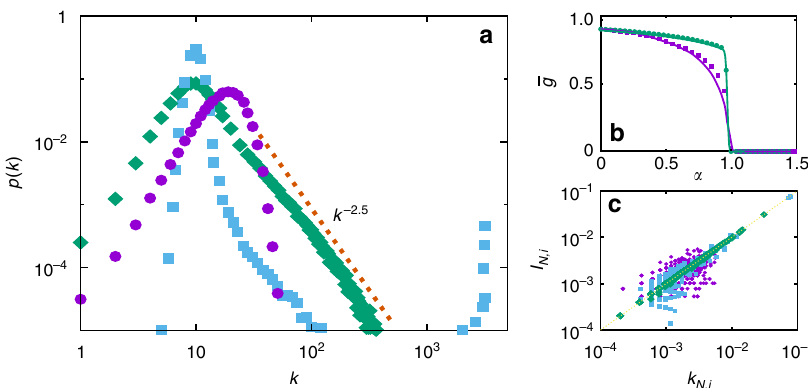
Fig. 1 Topological limit and coupling. a Stationary degree distributions p ∞ ( k ) for the three different phases: subcritical ( α = 0.8, purple circles), critical ( α = 1.0, green diamonds) and supercritical ( α = 1.2, blue squares). b Stationary homogeneity g ð α Þ for the topological limit ( γ = 1.0, purple squares), and for a different set of local probabilities ( π ð k Þ ¼ k α = k α h i N ð Þ and η ( k ) as before, green circles). The transition in the latter case is a discontinuous one, which fails to produce scale-free networks. The indicated lines follow from integration of the corresponding master equations, whereas points are Monte Carlo data. Deviations from simulations are due to the emergence of small degree – degree correlations that are not taken into account by the master equation. c Normalized current of each neuron, I N,i , as a function of its normalized degree, k N,i , showing the correlation between neural activity and topology that emerges in the system. The normalization is made by averaging over the total current ( 〈 I 〉 N )) and degree ( 〈 k 〉 N ) of the network, respectively. Labels as in a . Results are for N = 3200 and γ = 1.0, and data from Monte Carlo simulations have been averaged over 100 realizations. Error bars corresponding to s.d.